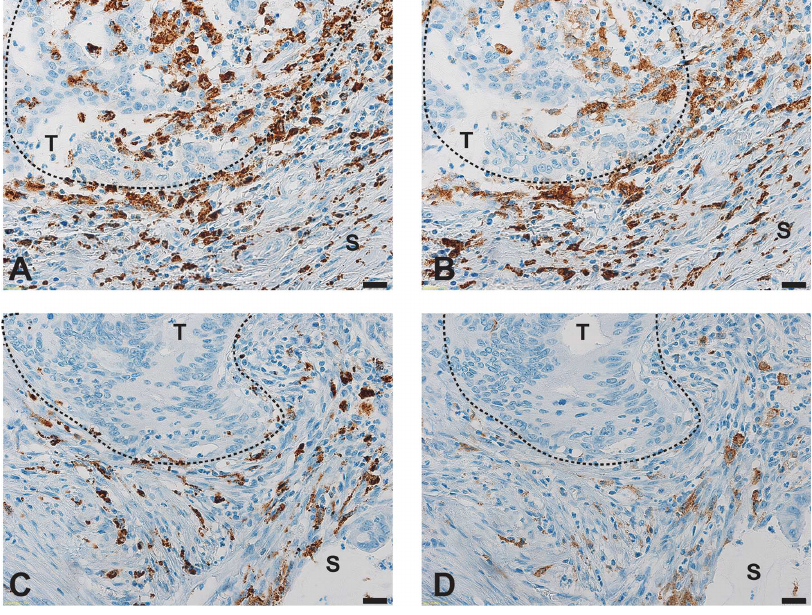
Fig 2. Distribution of macrophages in colorectalcancers,using CD68and CD163markers. Representative micrographsof (A, C) CD68+cellsand(B, D) CD163+cells(A, B) at theinvasivetumorfront(T) and(C, D) in the surroundingtumortissue(S). Magnification40X.Scalebar20 μ